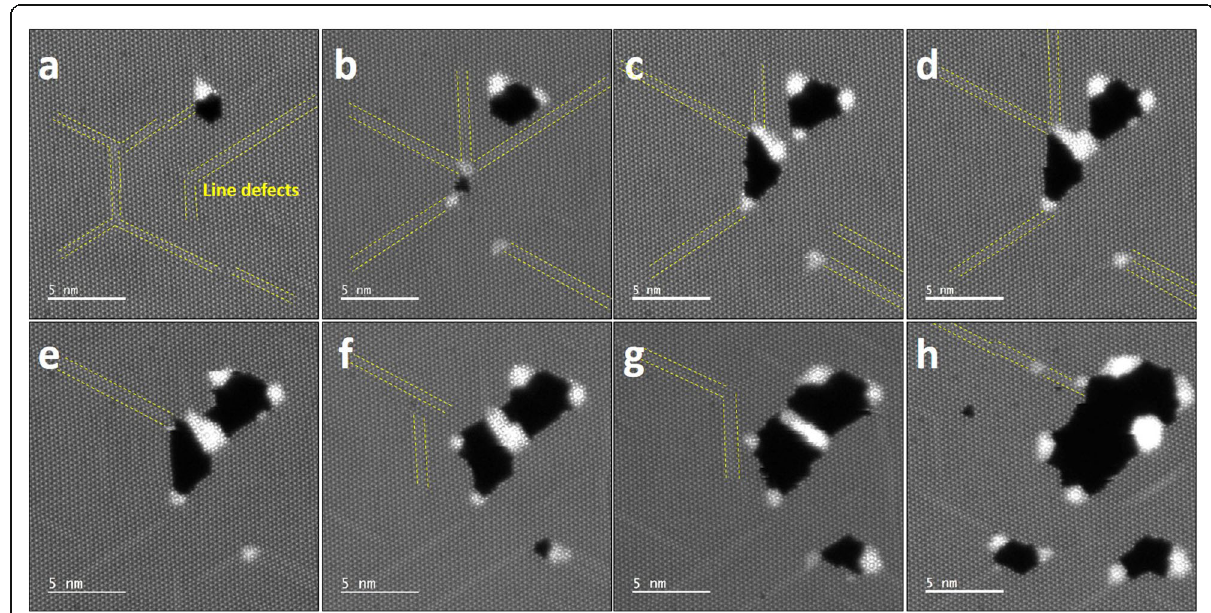
Fig. 2 Successive ADF-STEM images showing the formation of clusters initiated from line defects in the monolayer WS 2 . Yellow dashed lines indicate long line defects